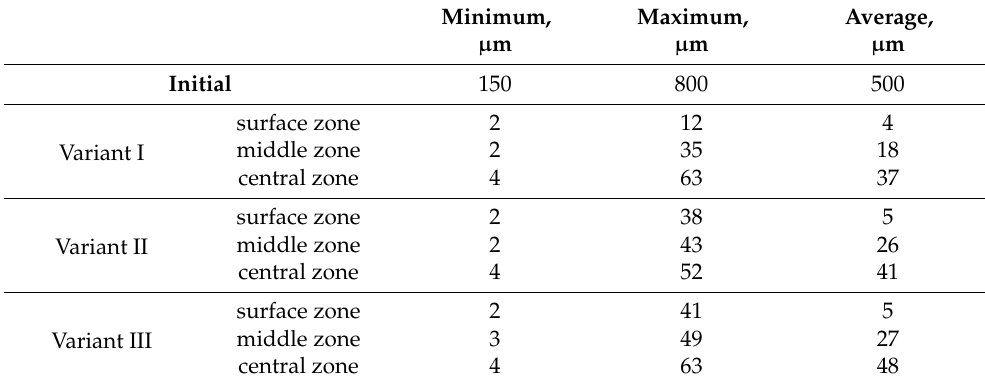
Table 4. Grain sizes for the analyzed variants of the RSR